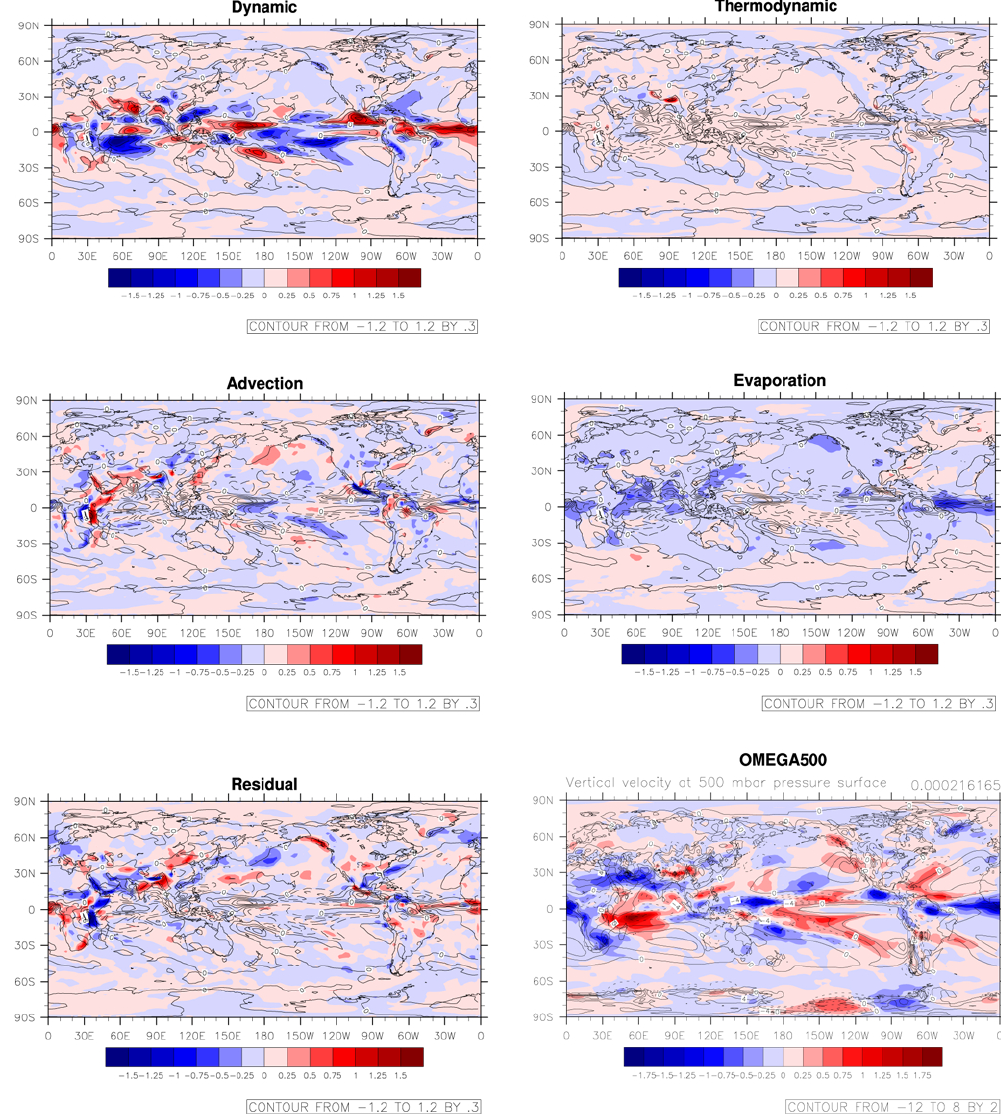
Fig. 13. Moisture budget analysis. Magnitude of each term is shown in colors and unit is mmday − 1 . Contour lines stand for precipitation change, calculated as SOMc minus SOMnc. Solid lines denote increases of precipitation and dash lines denote decreases of precipitation. Bottom right panel shows difference of 500mb vertical velocity at the pressure coordinate (color shading), and the contours stand for climatology of no-carbon run. The unit is 0.01Pas − 1